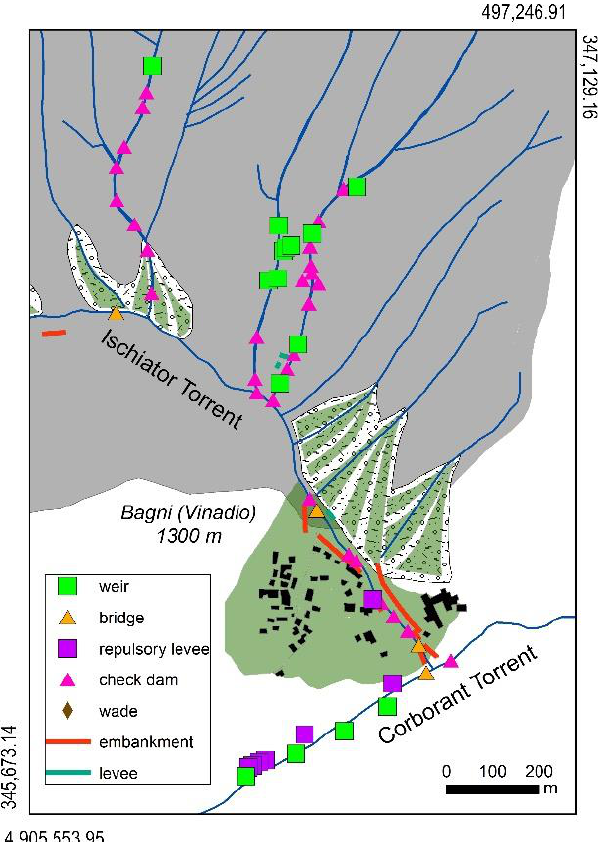
Figure 8. A detail of GIS map with the database of the interventions in the stream network (check dams, weirs, repulsory levees, embankments levees, bridges and wades are shown).